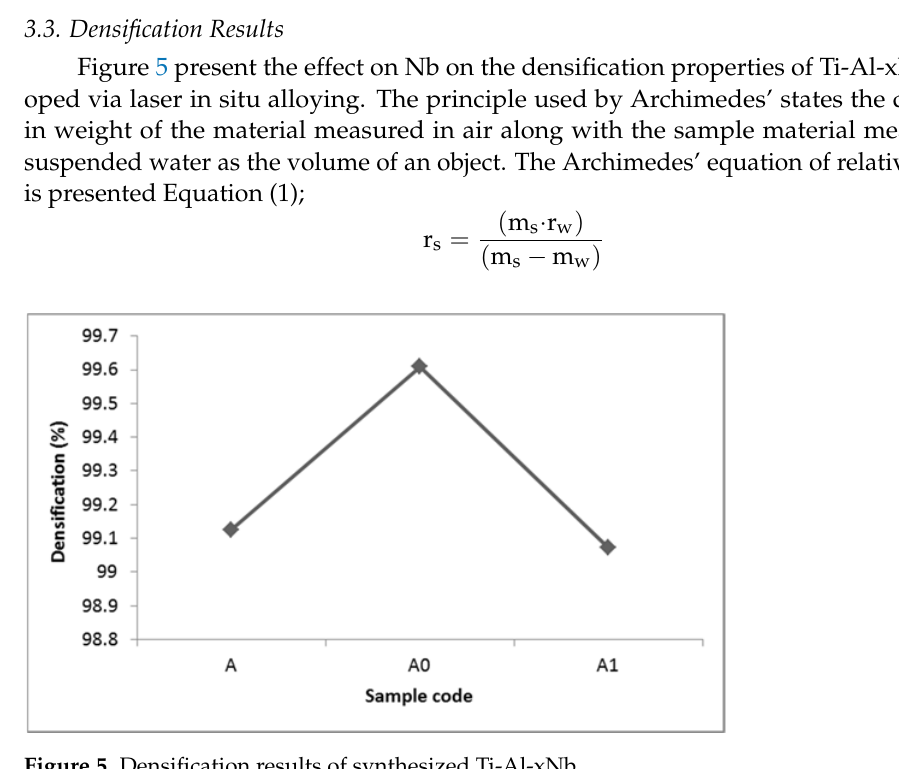
Figure 4. XRD plots of Ti-Al-Nb alloys.